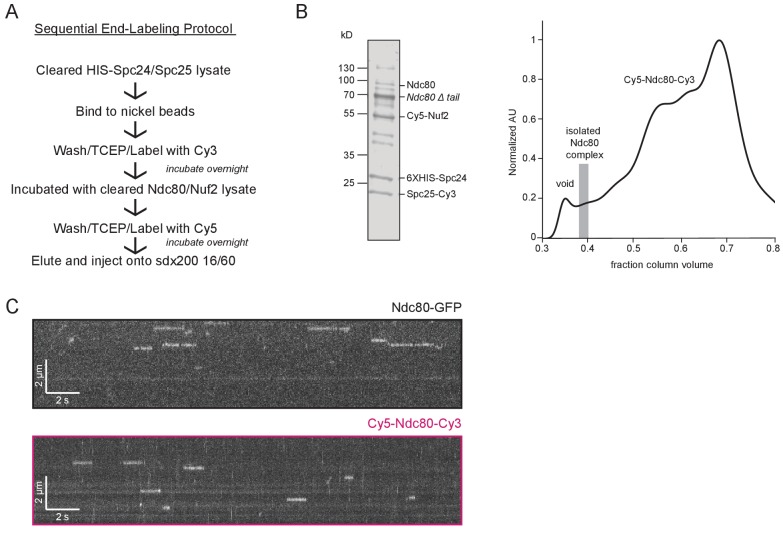
A functional Ndc80 complex can be sequentially end-labeled.(A) Schematic of sequential end-labeling procotol for the Ndc80 complex used in bulk FRET assay. (B) (Left) Coomassie blue-stained gel showing end-labeled Ndc80 complex used in bulk FRET assay (SEC fraction shown as gray bar in elution profile to the right). Sequential overnight incubation with dyes leads to greater complex degradation, especially of the N-terminal tail on the Ndc80 protein, as seen in gel. (Right) Representative Superdex 200 16/60 elution profiles of end-labeled Ndc80 complex (Nuf2 S2C, Spc25 S154C) (black trace) used in bulk FRET assay normalized to highest peak. Gray bar shows SEC fractions collected. (C) Representative kymographs of Ndc80-GFP (black box) and Cy5-Ndc80-Cy3 (pink box).